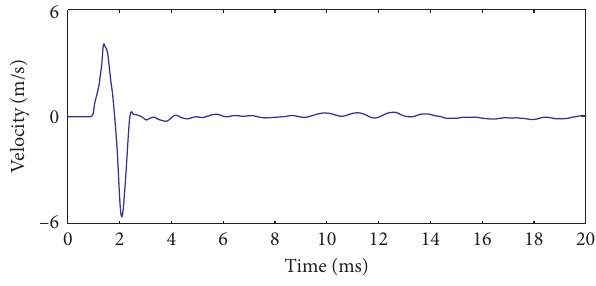
Figure 11: Velocity response signal.